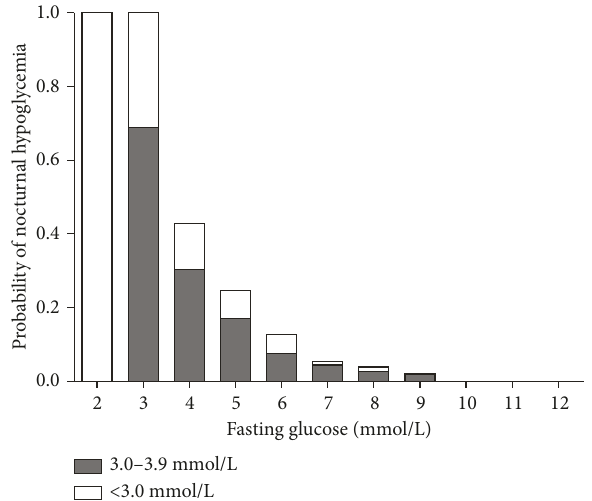
Figure 2: Risk of nocturnal hypoglycemia according to morning fasting glucose in 4,705 nights. Black bars, nocturnal hypoglycemia level 1 nights; white bars, nocturnal hypoglycemia level 2 nights.